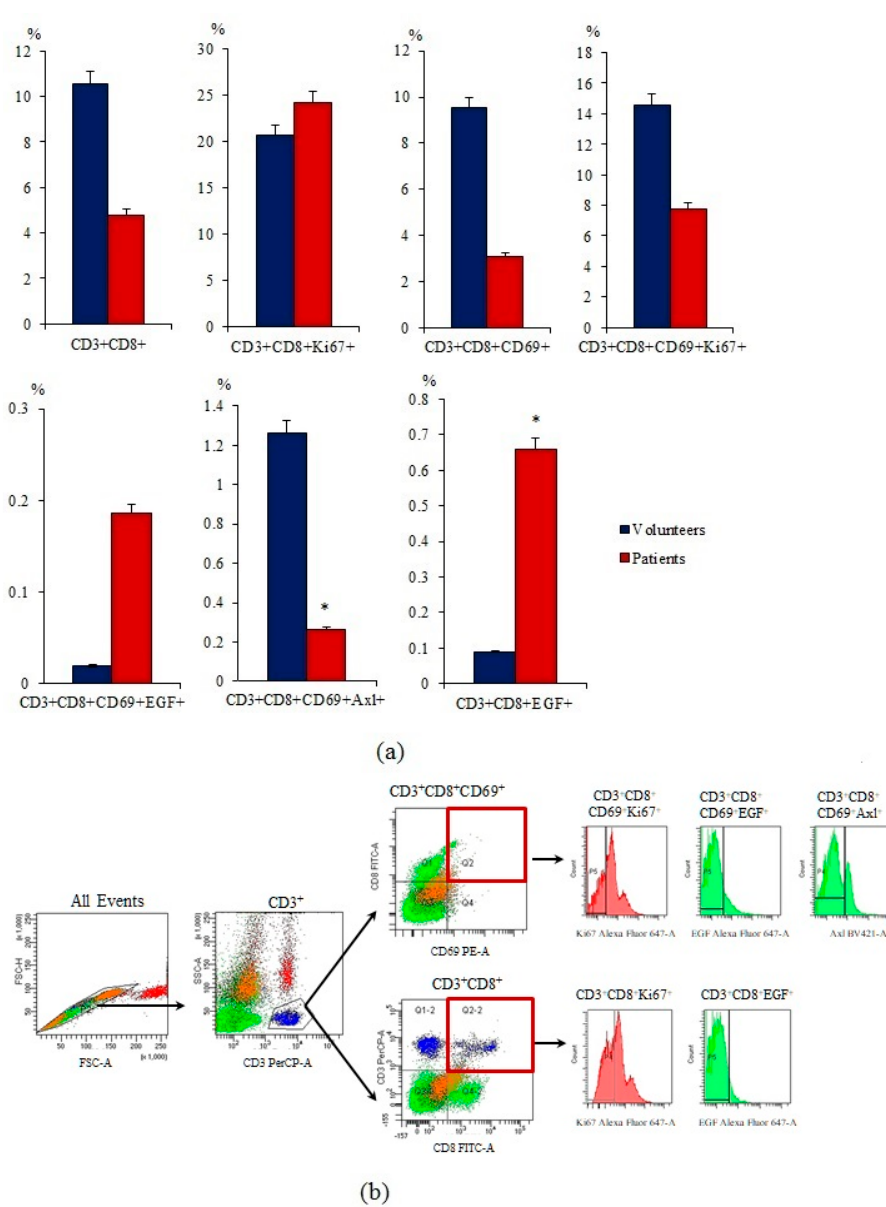
Figure 5. Characterization of CD3 + CD8 + T-lymphocytes in the blood of healthy volunteers and SCLC patients. ( a ) The content of CD3 + CD8 + , CD3 + CD8 + Ki67 + , CD3 + CD8 + CD69 + , CD3 + CD8 + CD69 + Ki67 + , CD3 + CD8 + CD69 + EGF + , CD3 + CD8 + CD69 + Axl + , and CD3 + CD8 + EGF + in the blood of healthy volunteers and SCLC patients (% of all labelled mononuclear cells); ( b ) cells were analyzed by flow cytometry using antibodies against CD3, CD8, CD69, EGF, Axl, and Ki67. Gating strategy for cytometry analysis of subpopulations from CD3 + CD8 + T-lymphocytes. * Differences are significant in comparison with volunteers ( p < 0.05).